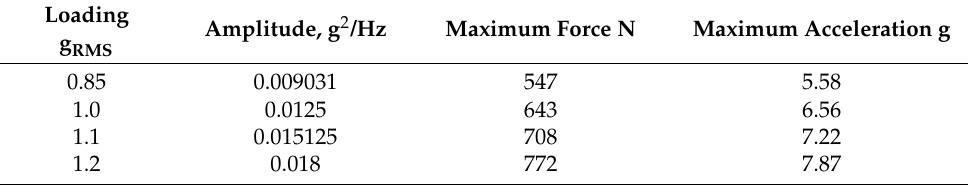
Table 2. Experimental loading conditions for kurtosis Ku = 4.